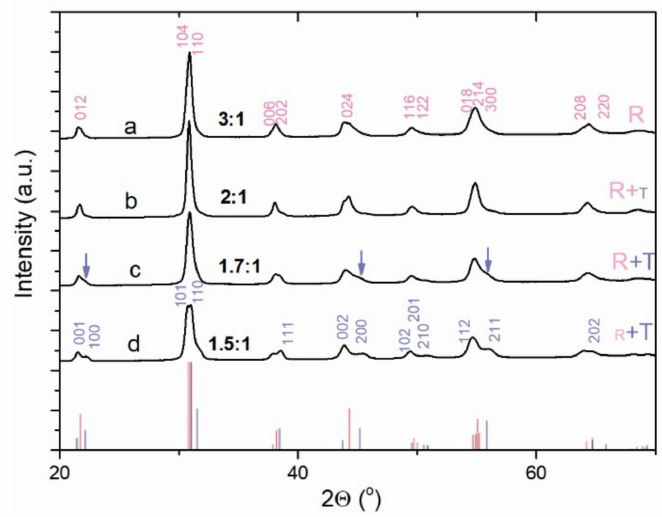
Figure 6. Powder XRD pattern of the PZT06 reaction product obtained through two-step precipitation process and hydrothermal reaction at 235 ◦ C (12 h) and at ( a ) KOH:Pb = 3:1, ( b ) KOH:Pb = 2:1, ( c ) KOH:Pb = 1.7:1, and ( d ) KOH:Pb = 1.5:1. The main diffraction lines of rhombohedral ( R ) and tetragonal ( T ) phase were indexed according to ICDD PDF reference code 01-070-4262 (S.G.: P4mm) and ICDD PDF reference code 04-012-9961 (S.G.: R3c), respectively. The prevailing phase is denoted by a larger letter. The blue arrows indicate the occurrence of some characteristic diffractions of the tetragonal